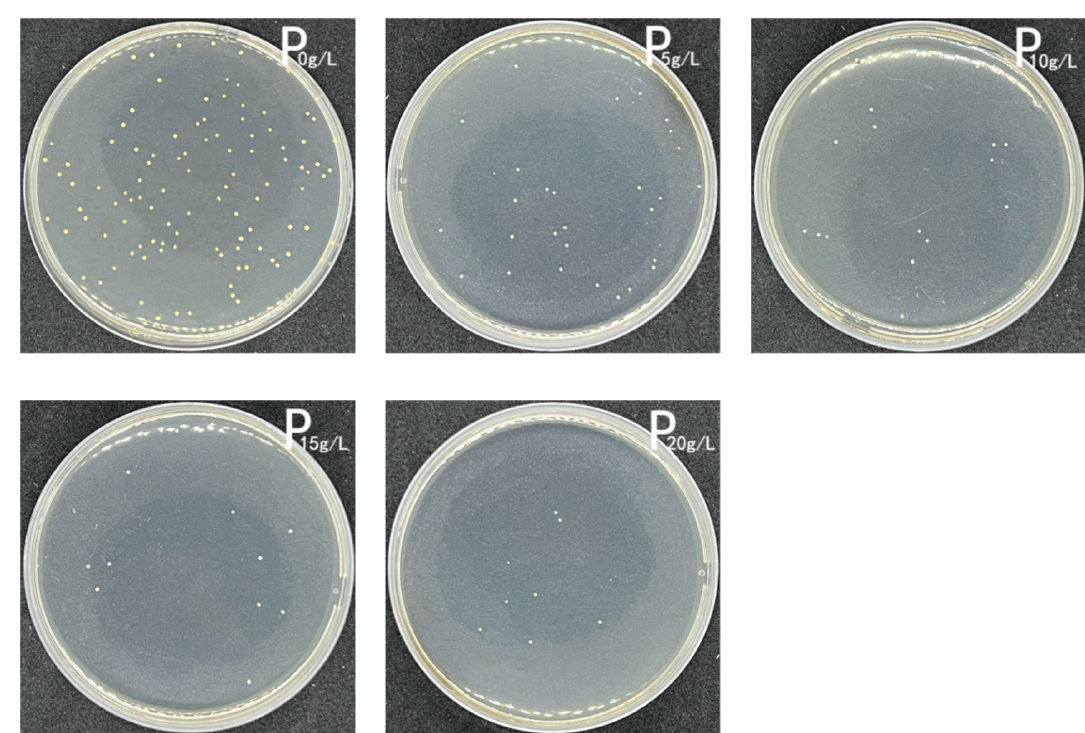
Figure 13. Inhibition of S. aureus by untreated cotton and antimicrobial cotton.